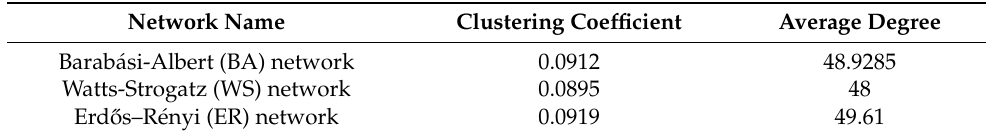
Table 3. Comparison of network parameters.